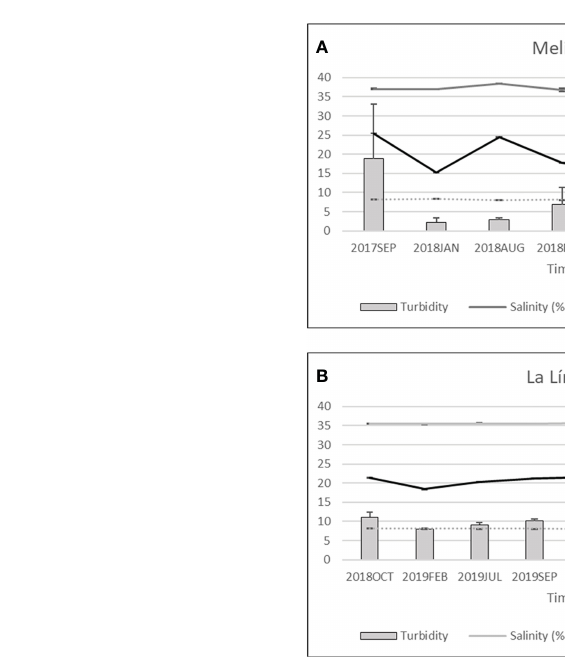
FIGURE 4 Physicochemical variables during the monitoring period. (A) Melilla; (B) La L ı ́ nea. Turbidity is represented by the right Y axis (ntu units), whereas salinity, temperature, and pH are all represented by the left Y axis. Salinity values for August and September 2019 in Melilla were not available due to an error with the